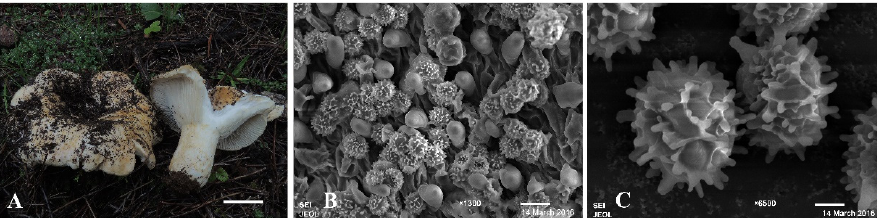
Figure 2. Basidiomata and microscopic structures of Russula subbrevipes (drawn from the holotype). ( A ) Basidiomata. ( B , C ) Basidiospores (SEM). Scale bars: ( A ) = 3 cm; ( B ) = 10 μ m; ( C ) = 2 μ m. Description—basidiomata medium-sized to large. Pileus 90–140 mm in diam., first hemispherical, expanding to plano-concave with a depressed center, then broadly infun- dibuliform when mature; margin incurved when juvenile, not becoming straight, smooth, without striate, sometimes dehiscent with age; surface yellow ochre (5C7) when fresh, becoming pale yellow (1A3) to cinnamon (6D6) when dry, slightly viscid when moist, gla- brous, smooth, without striate; suprapellis unpeelable; context hard, up to 5 mm thick towards center, white (1A1) when fresh, unchanging when bruising. Lamellae subdecur- rent, close to crowded with 1–3 series lamellulae, no forking near the stipe, white when fresh, becoming brownish-orange (5C3) to brown (5E5) when dry, unchanging when bruising. Stipe 40–50 × 10–25 mm, cylindrical, solid, cream (4A3) to white (1A1), becoming pale yellow (1A3) when dry, unchanging when bruising, glabrous or tomentose on the upper half part. Odor fruity. Taste mild. Spore-print whitish.